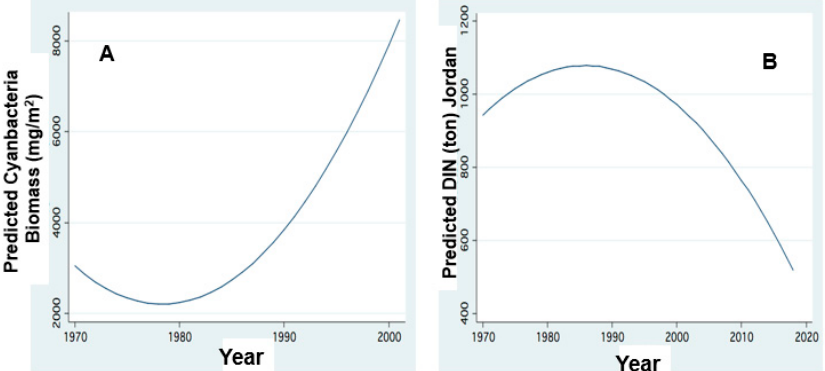
Figure 14. Temporal changes of Cyanobacteria biomass and DIN load. FP regression between: ( A ) Lake Wet Biomass (mg/m 2 ) of Cyanobacteria and Year; ( B ) Predicted annual DIN Jordan Loads (ton) and Year.